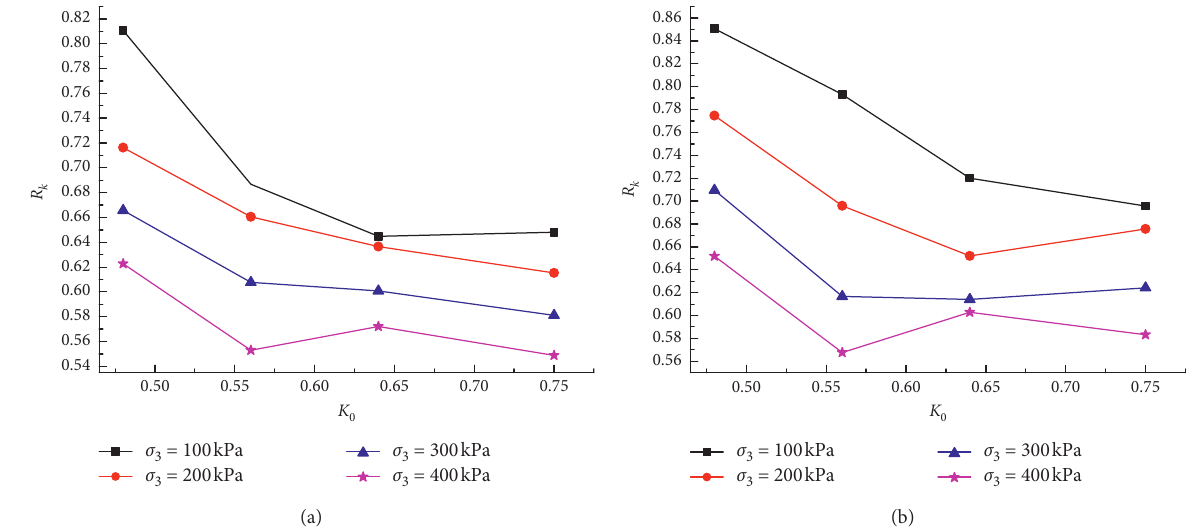
Figure 13: Relationship curves between the saturated permeability ratio R